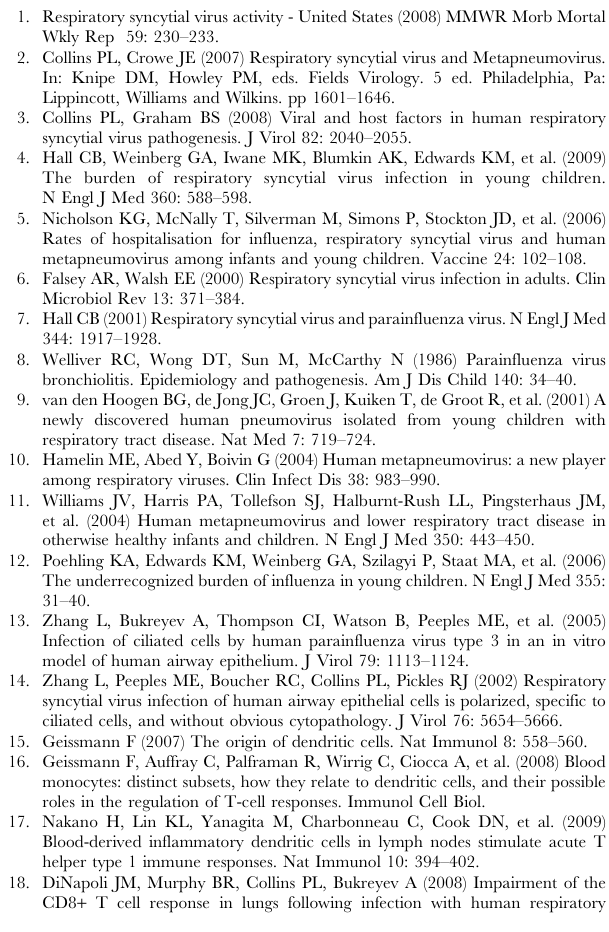
Figure S1 Memory phenotype of the proliferating CD4 + T cells. Proliferating CD4 + T cells (CFSE diluted T cells) were analyzed for naı¨ve or memory markers. MDDC derived from one donor were stimulated with the indicated virus at an MOI of 3 and co-cultivated with autologous CD4 + T cells at the ratio of 1 MDDC for 10 CD4 + T cells. The phenotype of the proliferating CD4 + T cells was evaluated on day 4, corresponding to the time of detection of the first proliferating cells (see Figure 2 A), and on day 7, corresponding to the time point when proliferation and cytokine production was evaluated for multiple donors (see Figure 2 C, and Figure 3 C and D). The percentage of live proliferated cells positive for CD45RA, CD45RO and CCR7 are